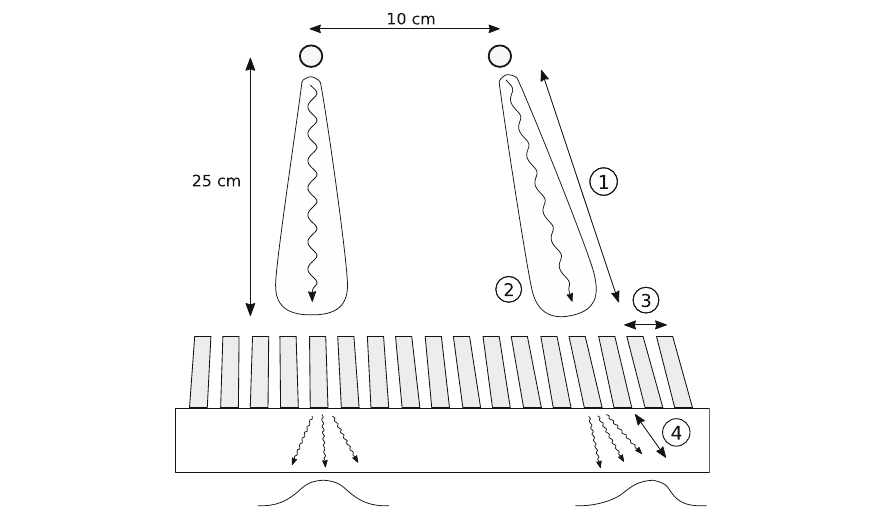
Fig. 3 Differences between a point source located in the middle of a focusing collimator versus one located toward the side. The effects corresponding to the numbers can be found in the text. It can be expected that the PSF of a point source located in the origin has a different shape than a point source toward the edge; the severity of this effect was studied in a simulation with point sources as located in the